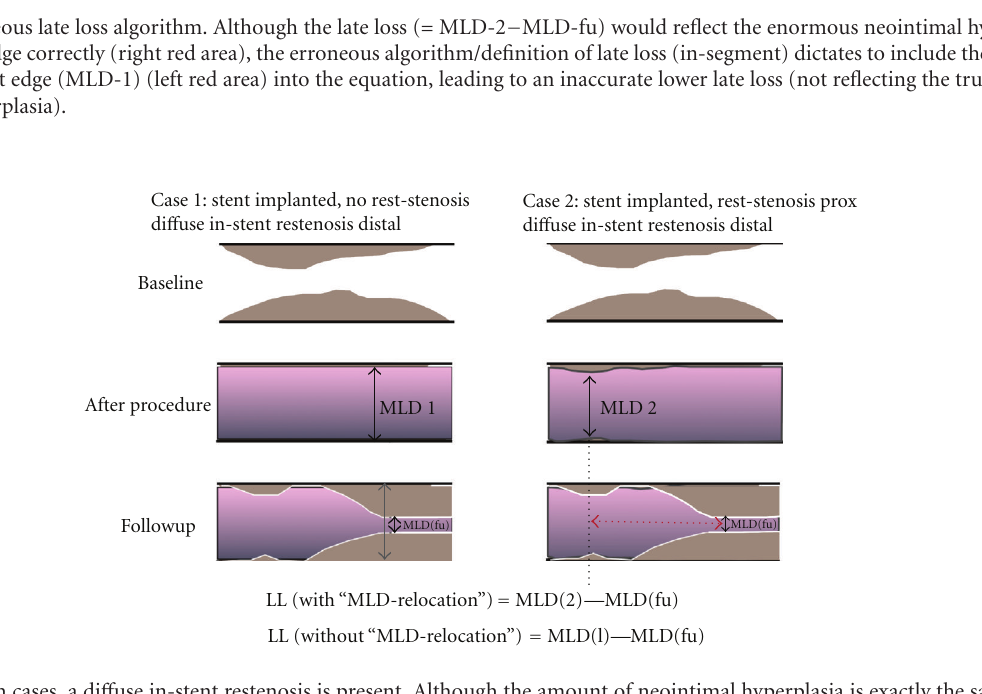
Figure 4: In both cases, a di ff use in-stent restenosis is present. Although the amount of neointimal hyperplasia is exactly the same, the late loss is significantly lower in case 2 due to the remaining MLD-2 after procedure (e.g., restrictive stenosis or nonadequately deployed stent). The red arrow indicates the distance of the MLD relocation from MLD-2 to